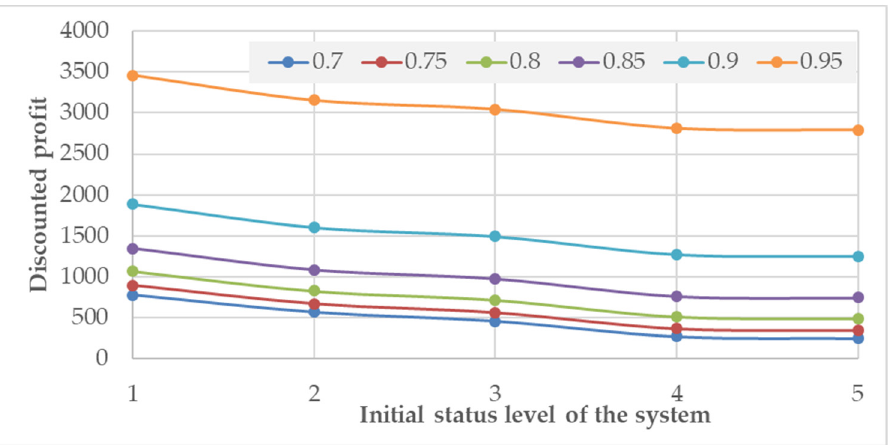
Figure 10. Impact of the initial system status on the discounted energy-consumption-based profit resulting from the optimized maintenance policy in the case of different discount parameters.